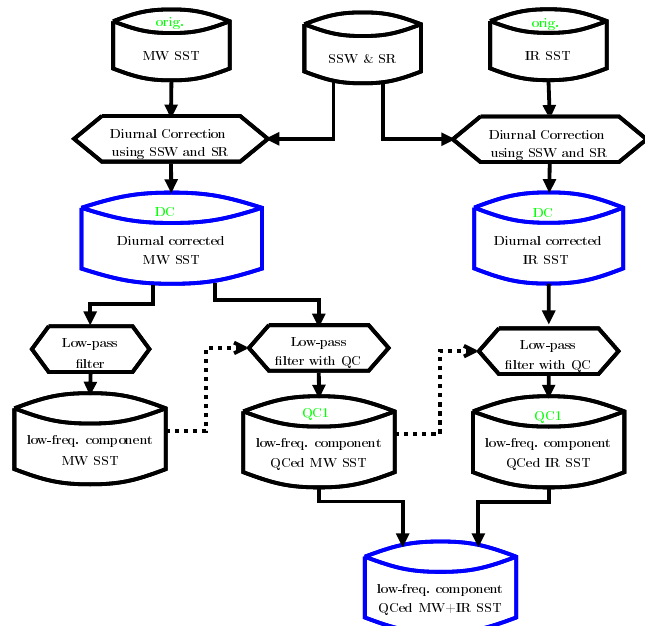
Figure 3. Flowchart of the data integration in this study for the low-frequency part. Dashed arrows denote the usage of the reference data for quality control (QC) of the input data indicated by solid arrows. Data storage indicated by blue color is used in the next step (Figure 4).